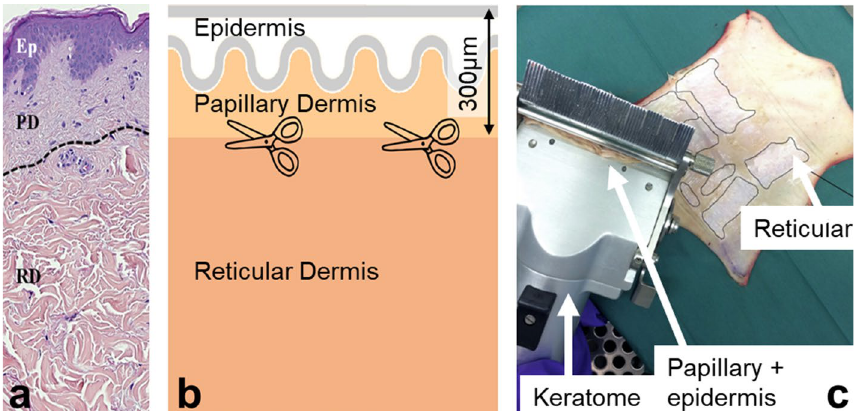
Figure 11. Splitting excised skin into two sub-layers using the keratome. ( a ) Histological section of normal human skin showing papillary (PD) and reticular (RD) dermis sub-layers (separated by a dotted line for clarity). Ep epidermis. Keratome separation at 300 µm roughly divides the two sub-layers ( b ). Keratomized areas on a skin sample ( c ) are shown with thin black